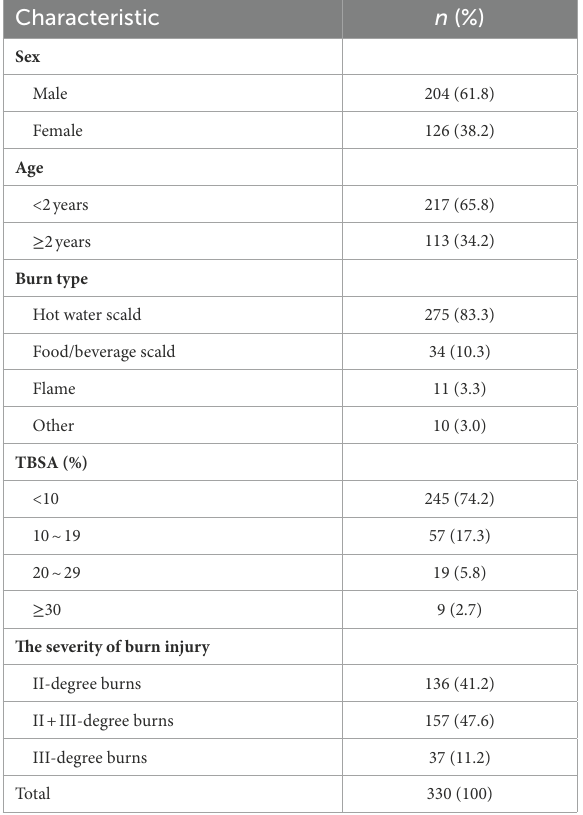
TABLE 1 Demographic and clinical characteristics of 330 burn wound infection cases.